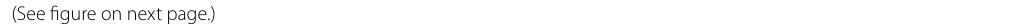
figure on next Fig. 3 OxLDL promoted the growth of ectopic endometrium in EMS animal models. A Three steps for establishment of the EMS animal model. B The ectopic endometrium in each group of EMS animal models. The scale bar represents 5 mm. ( C , D ) MVD in the ectopic endometrium from the two groups of animal models. The microvasculature was stained for CD34 by immunohistochemistry, while all the tissues were also stained by H&E and iron. The MVD was represented by the number of tubes in each field, and the numbers were counted with ImageJ software. The histogram represents the MVD in each group. The number in each group was